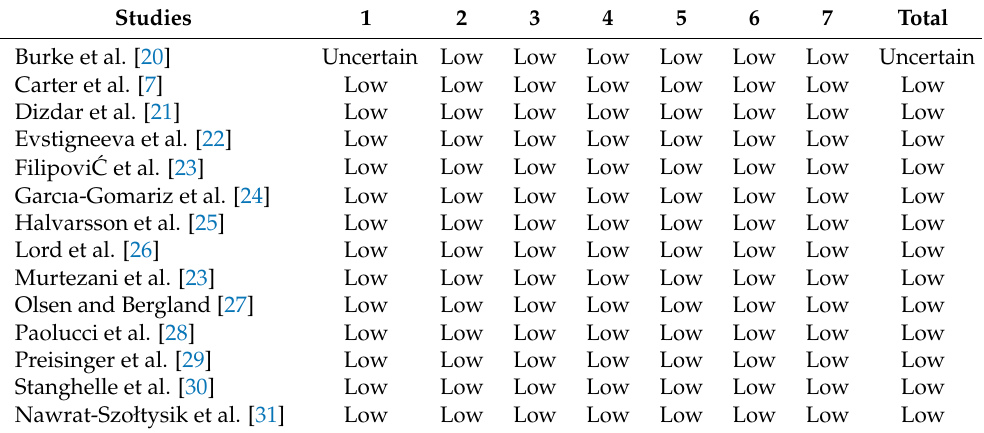
Table 1. Risk of bias analysis for randomized controlled trials (Cochrane Collaboration tool).